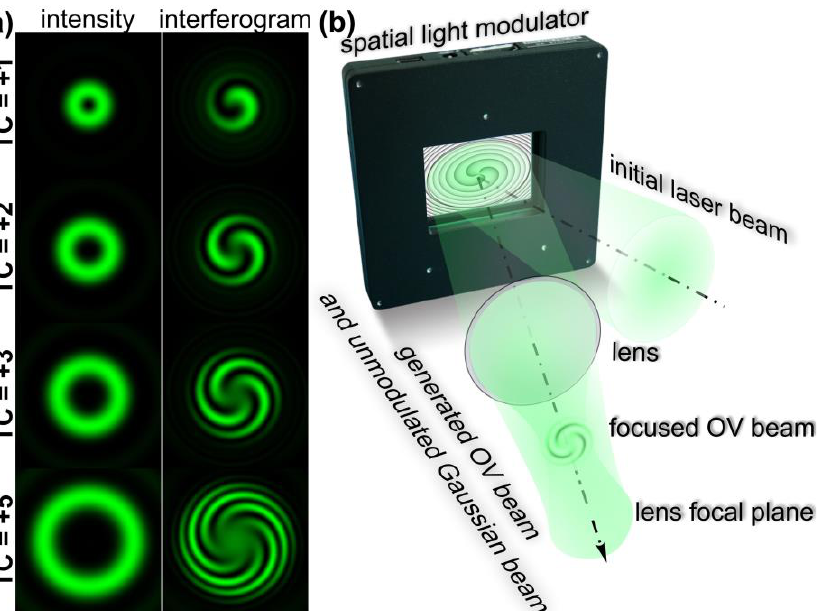
Figure 2. Generation of multi-spiral light interference fringes. ( a ) Intensity distributions of OV beams with different TCs and interference fringes generated as results of the interference of these OV beams with a Gaussian beam with a spherical wavefront. ( b ) Principle of generation of the multi-spiral interference fringes using a single spatial light modulator — multi-spiral light patterns are generated because of the interference of the non-modulated part of the initial Gaussian beam incident on the display of the modulator and a focused OV beam formed with a phase mask realized with the modulator. The generation of multi-spiral interference fringes is observed at the plane before the focal plane of the used lens, where the Gaussian beam with a spherical wavefront is formed.